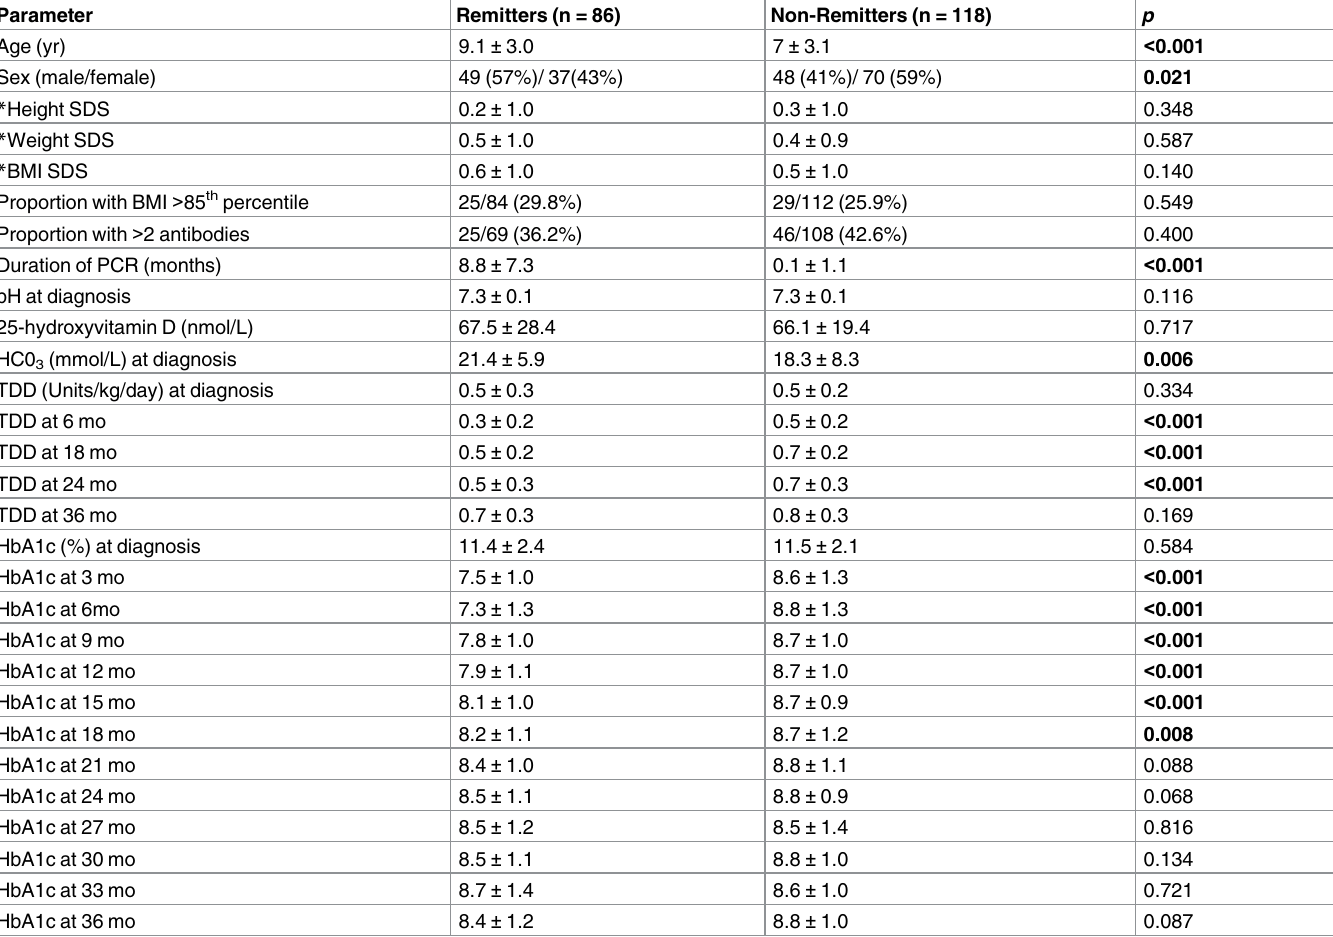
Table 1. Comparison of the anthropometric and biochemical characteristics of remittersand